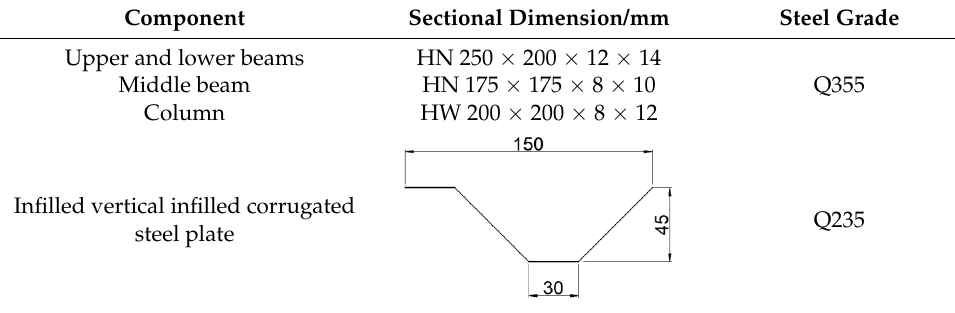
Table 1. Dimension details of test components [46].